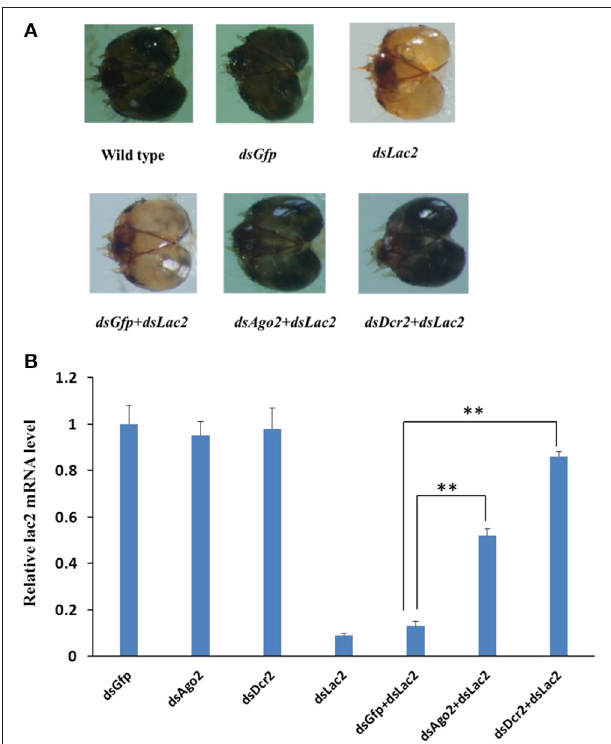
FIGURE 11 | Dcr2 and Ago2 RNAi efficiently suppressed the Lac2 RNAi. (A) Heads of a wild-type larva as well as larvae fed Gfp dsRNA, Lac2 dsRNA, Gfp dsRNA + Lac2 dsRNA, Ago2 dsRNA + Lac2 dsRNA, or Dcr2 dsRNA + Lac2 dsRNA. Both Ago2 and Dcr2 RNAi, but not Gfp RNAi, suppressed the Lac2 RNAi phenotype. (B) Relative lac2 expression level based on a qRT-PCR. The Lac2 expression level was higher in larvae fed Ago2 dsRNA or Dcr2 dsRNA than in control larvae (i.e., fed Gfp dsRNA + Lac2 dsRNA). Data were analyzed using Student’s t -test (** p <